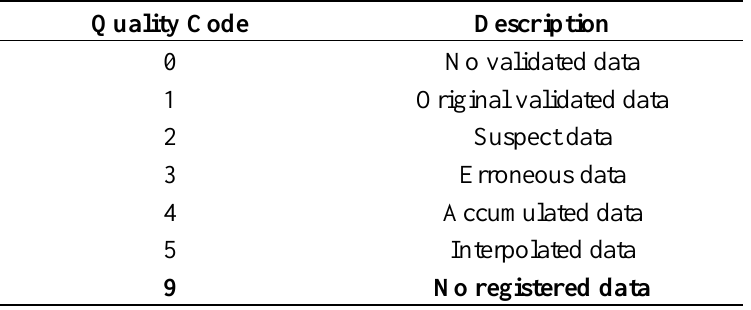
Table 4. Quality flags of the measurements provided by the